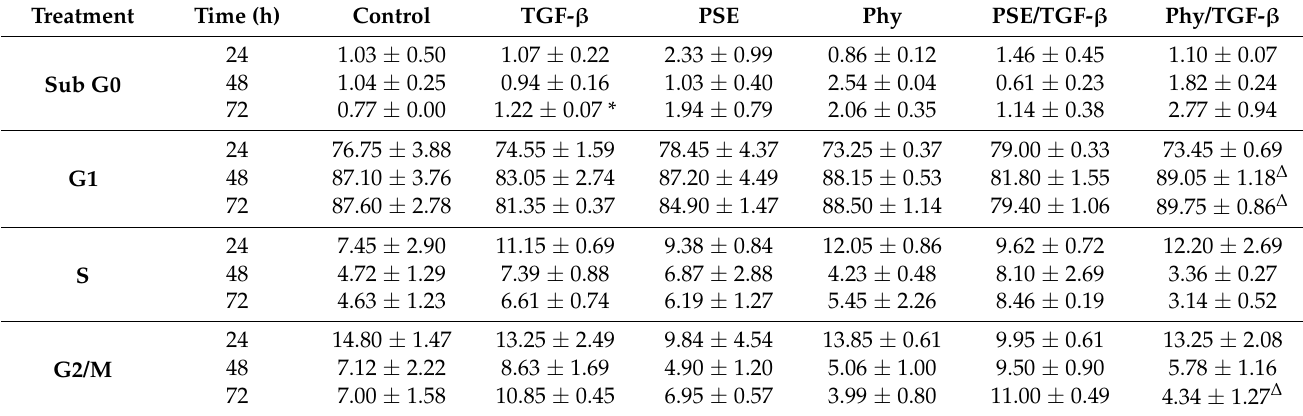
Figure 5. Representative diagrams for cell cycle phase distribution in MCF-10A cells. Cells were exposed to 30 ng/mL of TGF- β (Transforming growth factor beta) for 7 days and subsequently stimulated with PSE and Phy for 72 h. Table 5. Cell cycle phase distribution of MCF-10A cells in the presence or absence of 30 ng/mL TGF- β and PSE or Phy for 24, 48 and 72